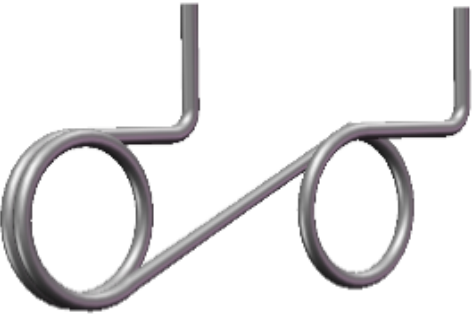
Figure 6. Schematic of spring tooth.